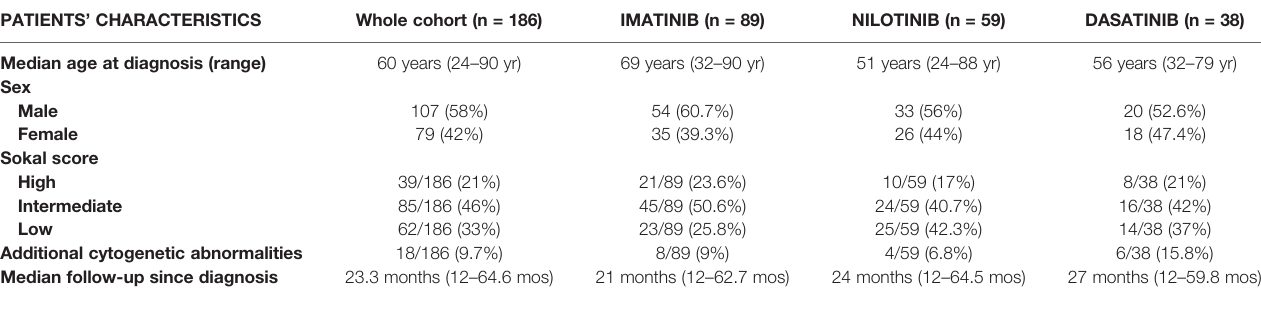
TABLE 1 | Patients ’